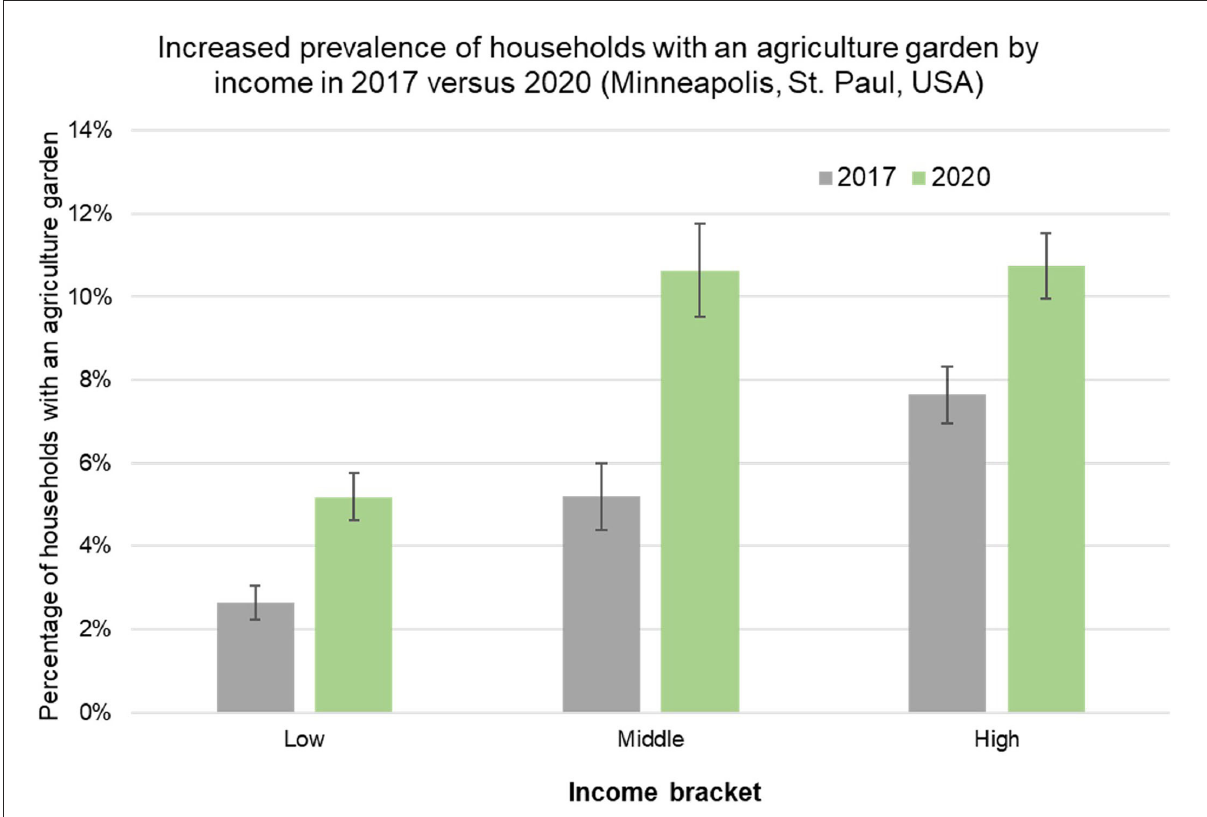
FIGURE5 Prevalence of households with an agriculture garden by income in the Twin Cities (Minneapolis and St. Paul, MN, USA) in the summer of 2017 (gray) and 2020 (green). Error bars illustrate the 95% confidence interval of the